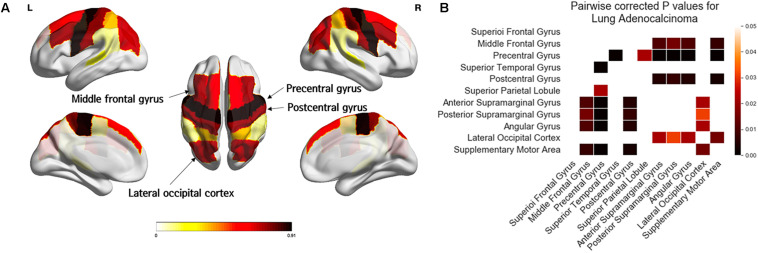
Comparison of the frequency of brain metastases from adenocarcinoma by subregions of the distal ACA and MCA territories. Yellow regions indicate a low frequency of brain metastases (BMs) while black regions indicate a high BM frequency (A). Tukey’s HSD post-hoc pairwise test for comparison of BM frequency between subregions in the distal ACA and MCA territories. All colored cells indicate a significant difference between two regions (p < 0.05). Darker colors indicate greater differences in BMs between two regions (B). ACA; anterior cerebral artery; MCA, middle cerebral artery.